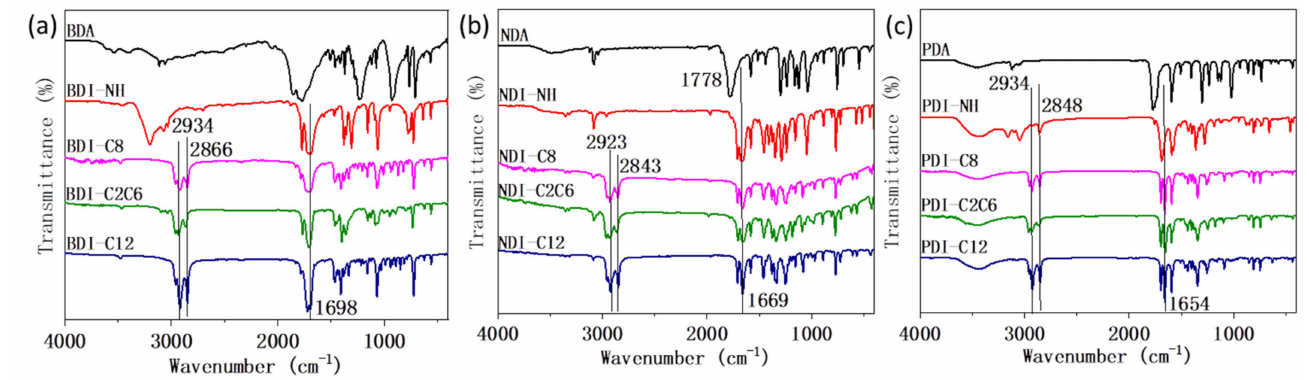
Figure 7. FTIR spectra of: ( a ) BDI-, ( b ) NDI-, and ( c ) PDI-based